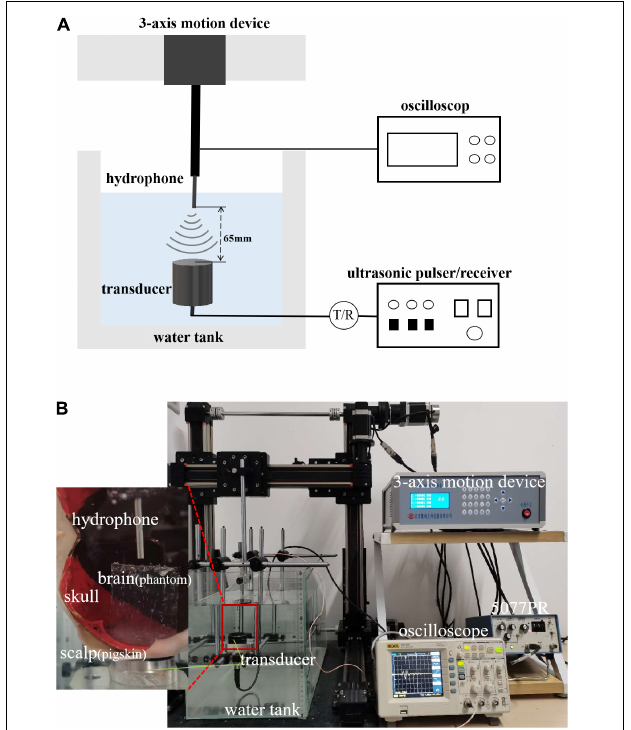
FIGURE 3 | (A) Layout of experiment equipment. The experimental system consisted of a water tank, 3-axis motion device, hydrophone, ultrasound transducer, ultrasonic pulser/receiver, and oscilloscope. (B) Scene of experiment. The figure shows the equipment and its corresponding position. The relation of the equipment to the position of the samples (scalp, skull bones, and brain tissue) is also shown.